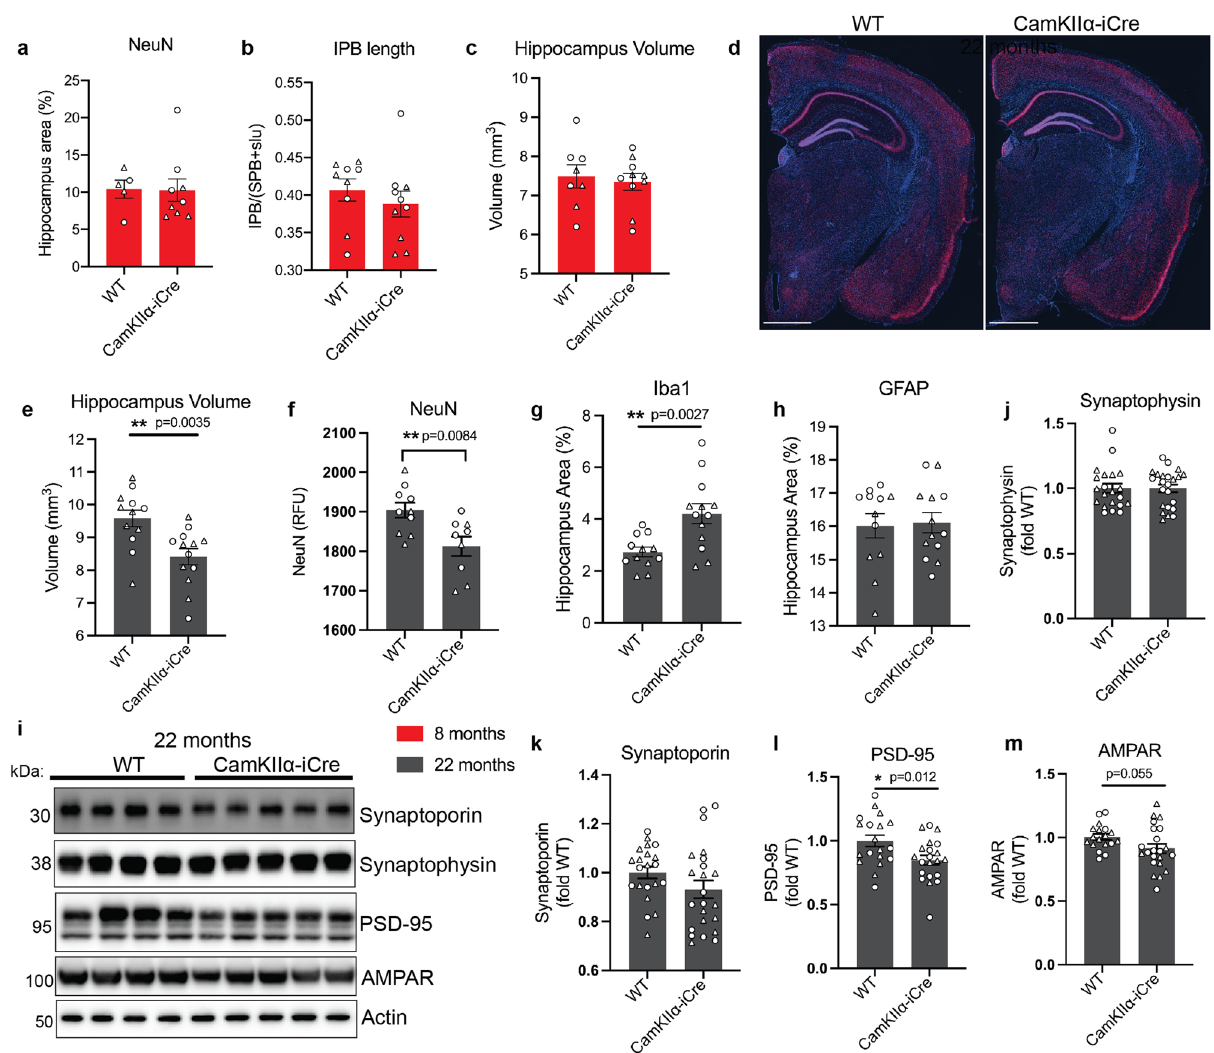
Figure 5. Hippocampal volume is reduced in aged CaMKII-iCre mice. Quantifications of NeuN covered area (A) and intrapyramidal bundle (IPB) length (B) in the hippocampus of 8-month-old WT and CaMKIIα-iCre mice. Immunofluorescence microscopy of representative coronal brain sections for synaptoporin and NeuN are shown in Fig. 4D. IPB lengths were normalized to the length of the suprapyramidal bundle (SPB) and stratum lucidum (slu) and expressed as a ratio of IPB/SPB + slu. (C) Quantification of hippocampus volumes (mm 3 ) in 8-month-old WT and CaMKIIα-iCre mice. (D) Representative coronal brain sections from female 22-month-old WT and CaMKIIα-iCre mice labeled for NeuN (red) and DAPI (blue). Scale bar, 1000 µm. (E) Quantification of hippocampus volumes (mm 3 ) in 22-month-old WT and CaMKIIα-iCre mice. (F) Quantification of NeuN immunostaining in the hippocampus of 22-month-old WT and CaMKIIα-iCre mice. Quantification of Iba1 (G) or GFAP (H) percentage of area covering the hippocampus from WT and CaMKIIα- iCre mice (WT, n = 12; CaMKIIα-iCre, n = 13). (I) Immunoblot of hippocampal homogenates from 22-month- old WT and CaMKIIα-iCre mice probed for synaptophysin, synaptoporin, PSD-95, AMPAR and actin. Original immunoblots are shown in Fig. S6. Quantification of synaptophysin (J) , synaptoporin (K) , PSD95 (L) and AMPAR (M) immunoblots in (I) normalized to actin and expressed as fold of WT. (WT, n = 17; CaMKIIα-iCre, n = 20). Circles = females, triangles = males. Unpaired t-test was performed for all quantifications and values are mean ±